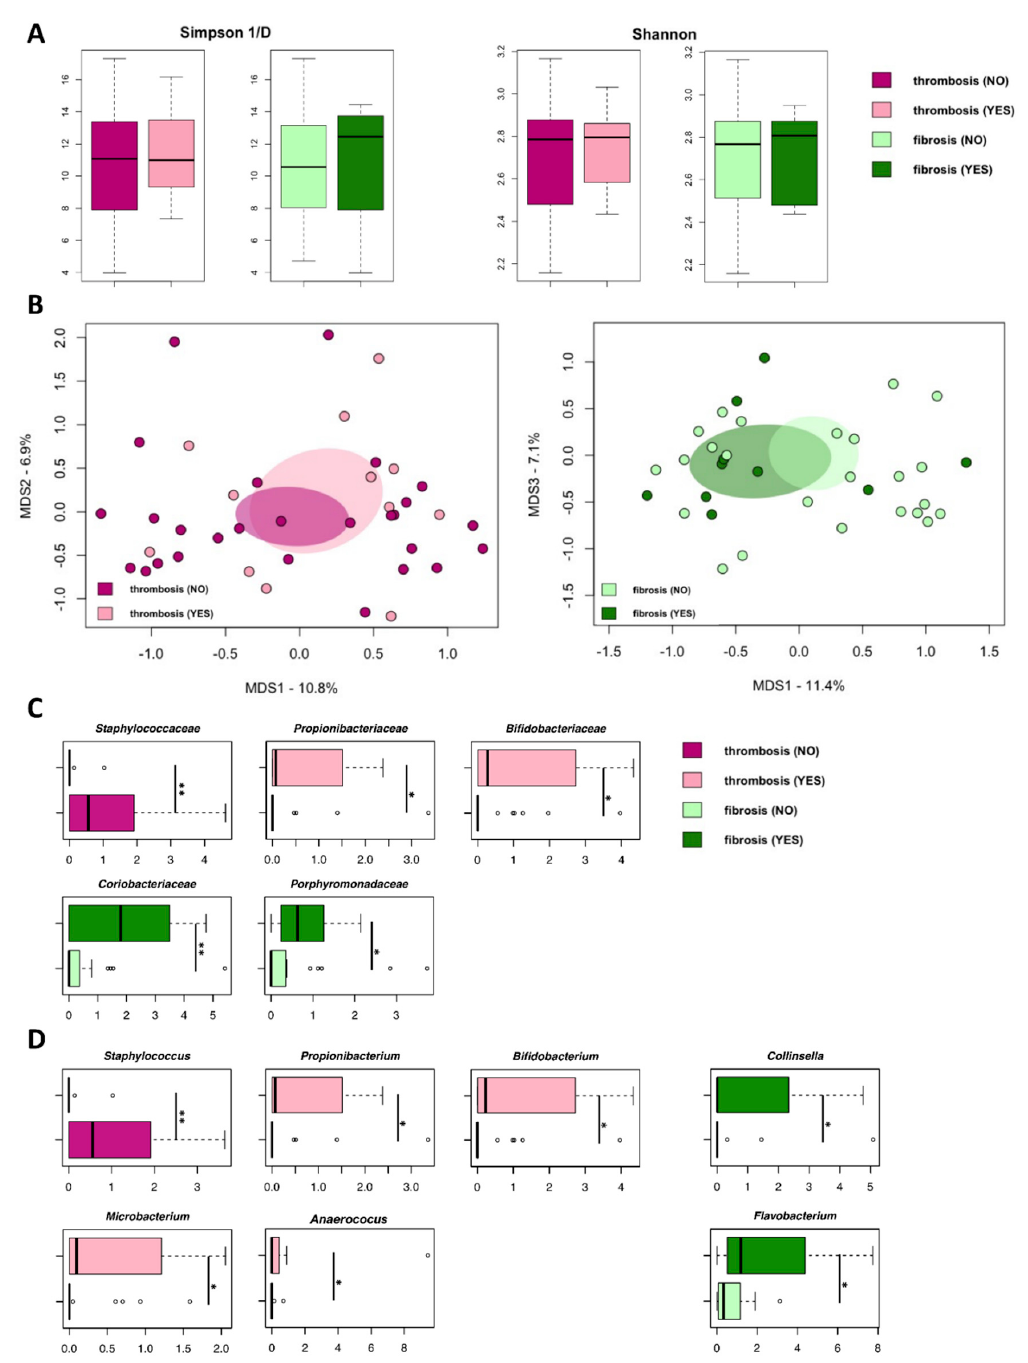
Figure 4. Microbial DNA signatures of thrombosis history and marrow fibrosis in EVs isolated from the plasma of PV patients. ( A ) Alpha diversity, estimated according to the inverse Simpson and Shannon indices, of the microbial DNA cargo of EVs isolated from PV patients stratified by the occurrence of thrombosis or marrow fibrosis. No significant differences were found ( p ≥ 0.06, Wilcoxon rank-sum test). ( B ) Principal coordinates analysis (PCoA) based on Jaccard similarity between the genus-level profiles of EVs isolated from the plasma of PV patients, stratified as above. No significant segregation was found between study groups ( p ≥ 0.3, PERMANOVA). Boxplots showing the relative abundance distribution of families ( C ) and genera ( D ) that were significantly differentially represented between PV patients with and without history of thrombosis or marrow fibrosis (* p < 0.05; ** p < 0.01; Wilcoxon rank-sum test).